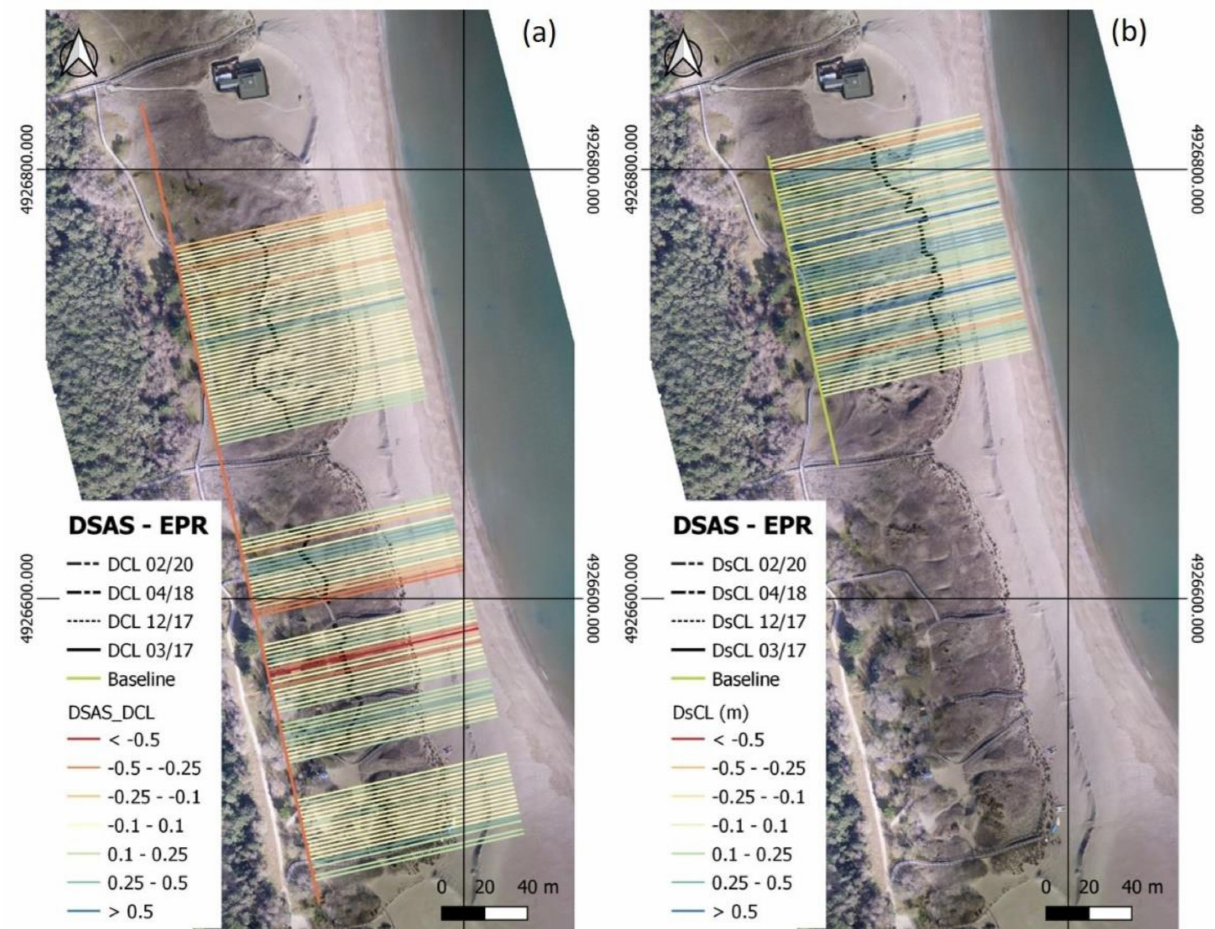
Figure 9. EPR results from DSAS analysis, in GIS: ( a ) the dune crest line; ( b ) the dune seaward crest